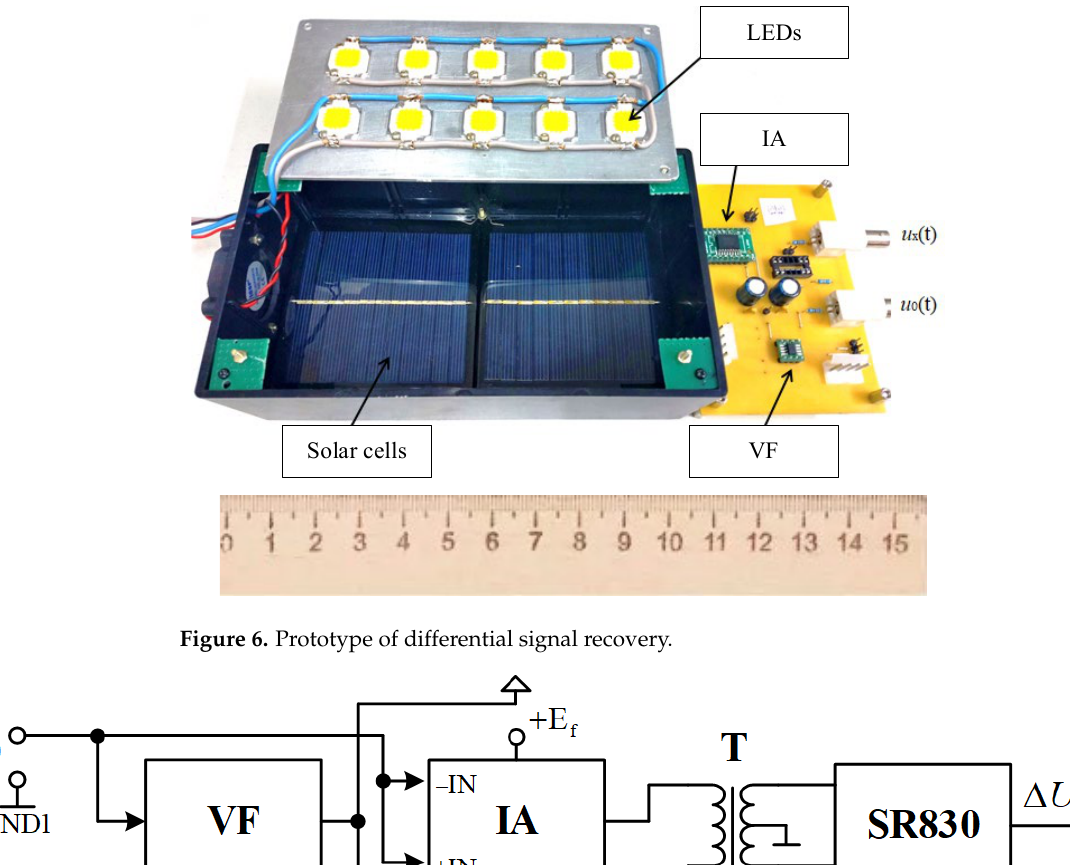
Figure 7. Schematic circuit of CMRR detection in the prototype of differential signal recovery. Table 2. CMRR values for the differential signal